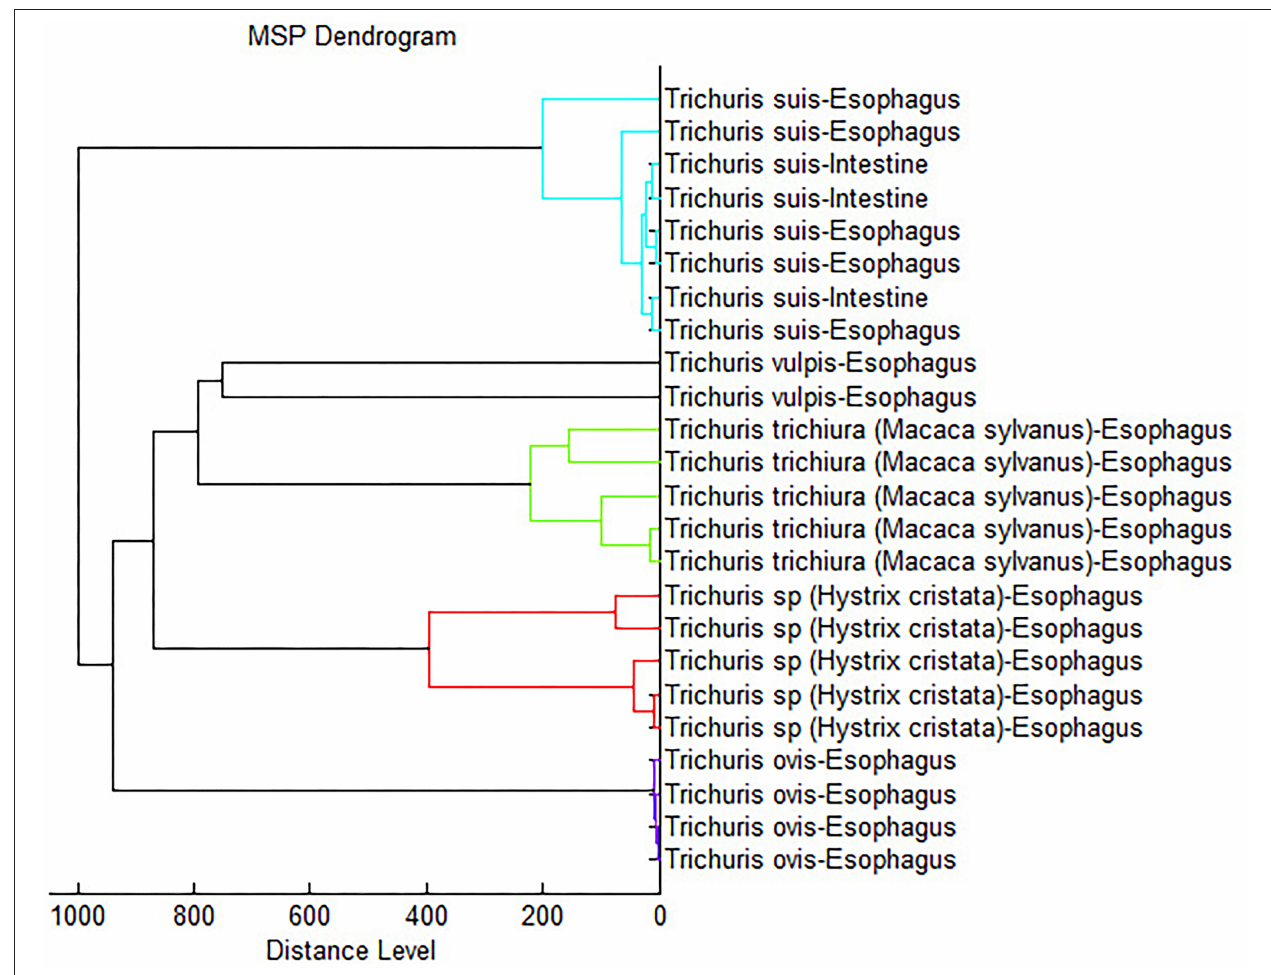
FIGURE 4 | Dendrogram analysis constructed using representative spectra of each Trichuris species used to develop the internal database.